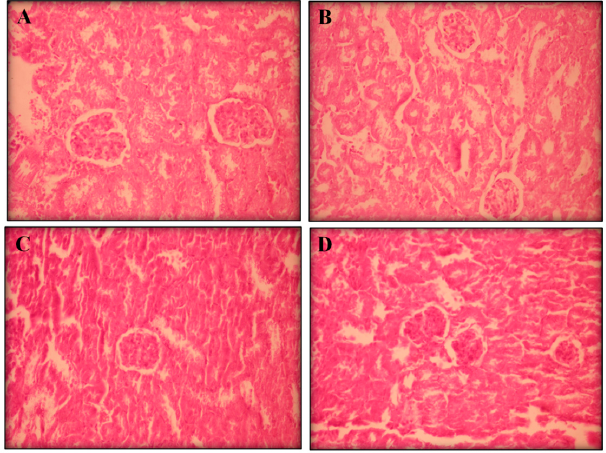
Figure 4. The effect of perillaldehyde 8,9-epoxide on kidneys of healthy mice. Histopathology was analyzed by light microscopy and stained with hematoxylin-eosin (400×). Photos from liver represent: negative control ( A ); positive control 25 mg/kg/day 5-FU-treated ( B ); 100 mg/kg/day perillaldehyde 8,9-epoxide treated ( C ); and 200 mg/kg perillaldehyde 8,9-epoxide treated ( D ).